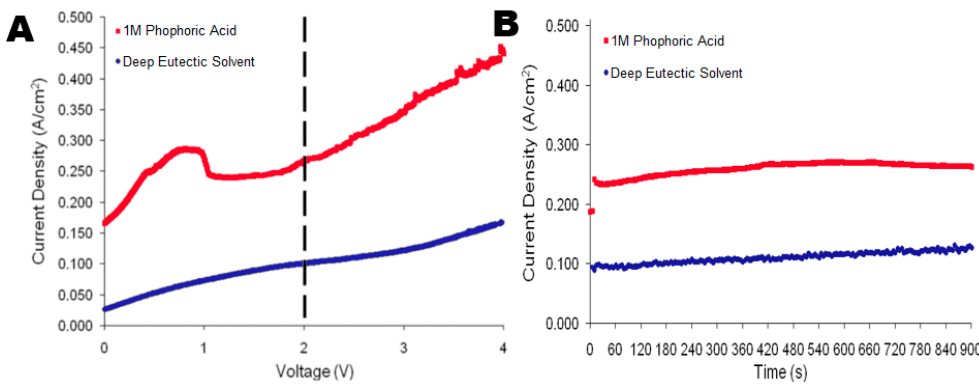
Figure 2. Linear sweep voltammograms ( A ) for both polishing agents with aluminum samples stepped